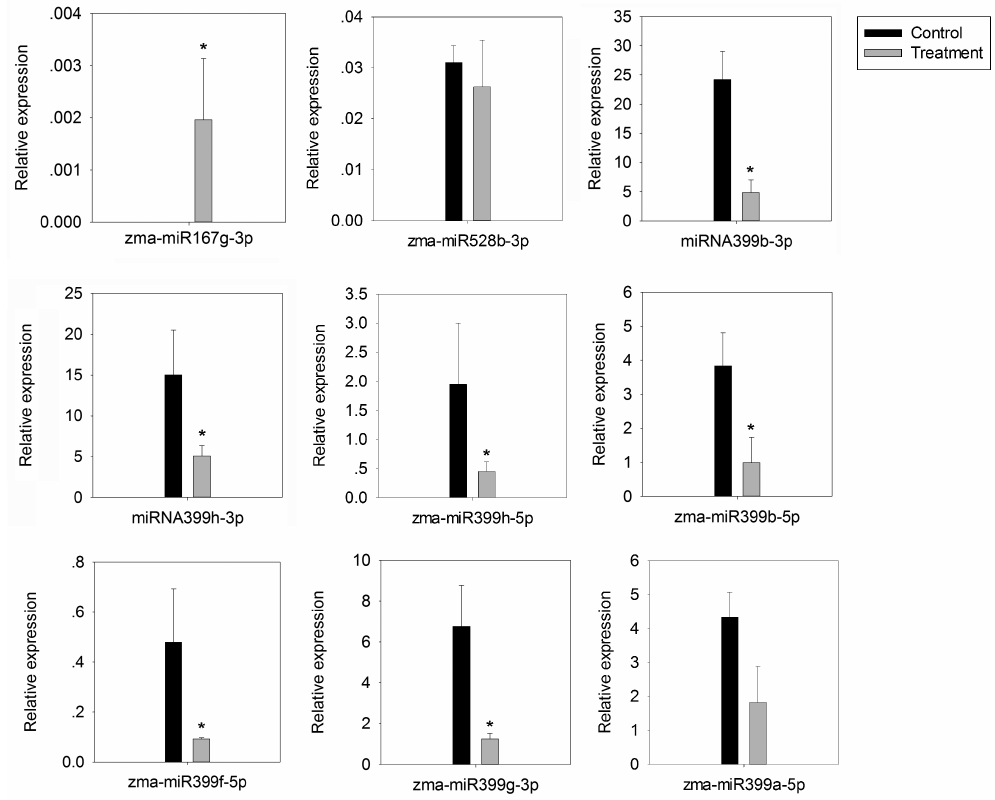
Figure 4. Quantitative reverse transcription polymerase chain reaction (qRT-PCR) validation of expression profiles of nine miRNAs. The house-keeping gene 5S rRNA was used as the internal control, and Error bars represent SD from three replicates. Asterisk indicates statistically significant differences between control and AM infected maize (* p < 0.05). Student t -test was used to assess significant